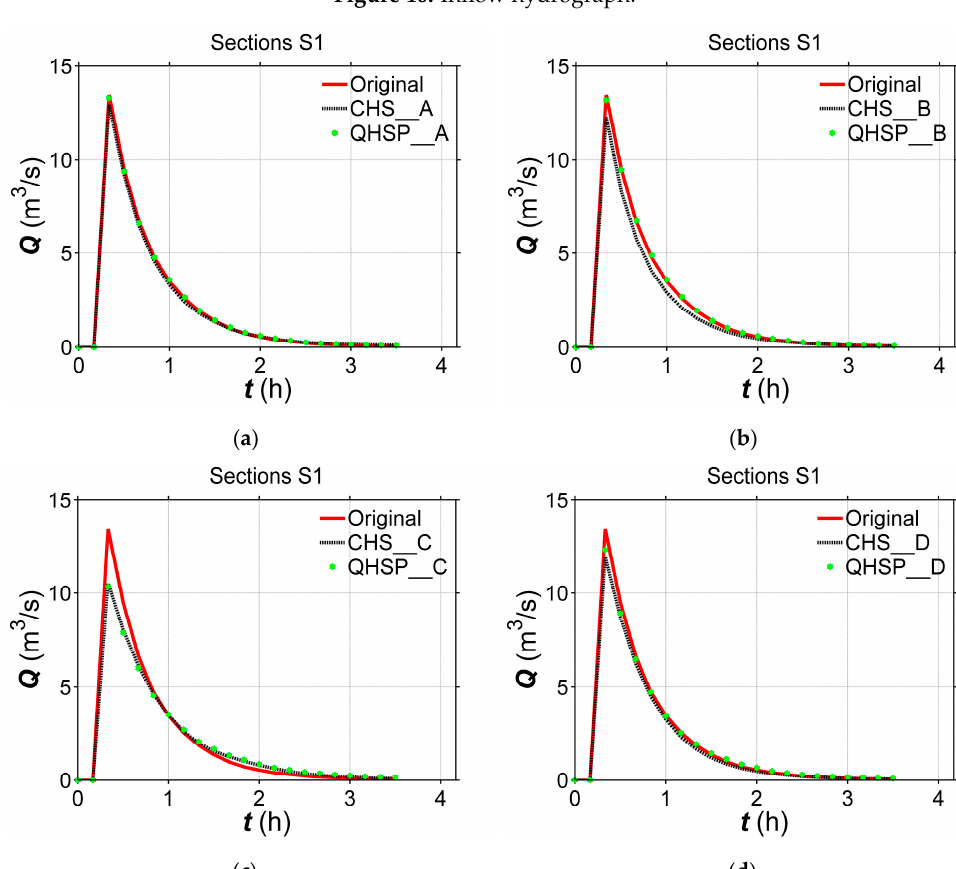
Figure 11. Computed hydrograph for test case ( a ) A, ( b ) B, ( c ) C, and ( d ) D at Section S1 in the constructed river with the amplitude of 600 m.